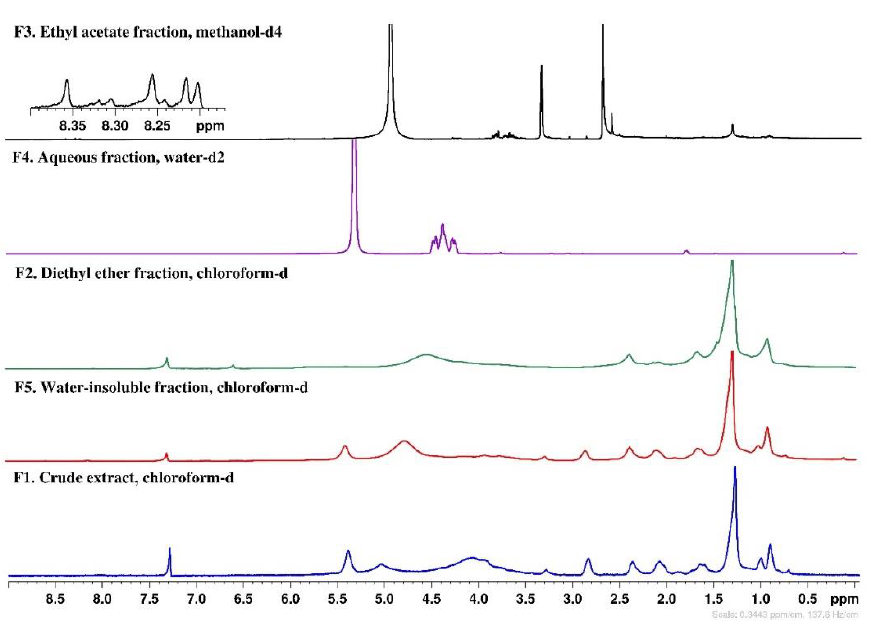
Figure 8. 1 H NMR spectra (400 MHz) of Saccorhiza polyschides fractions.